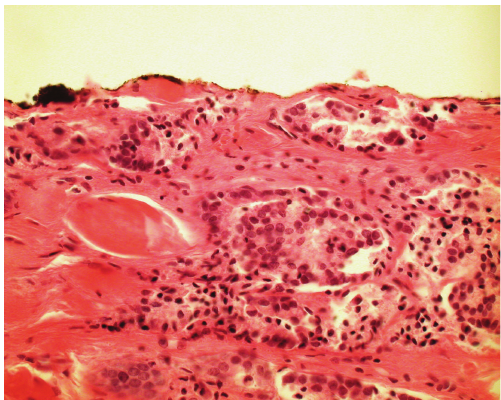
Figure 1: Prostatectomy specimen with a definite positive surgical margin (PSM). The inked resection margin transects tumor (400x).